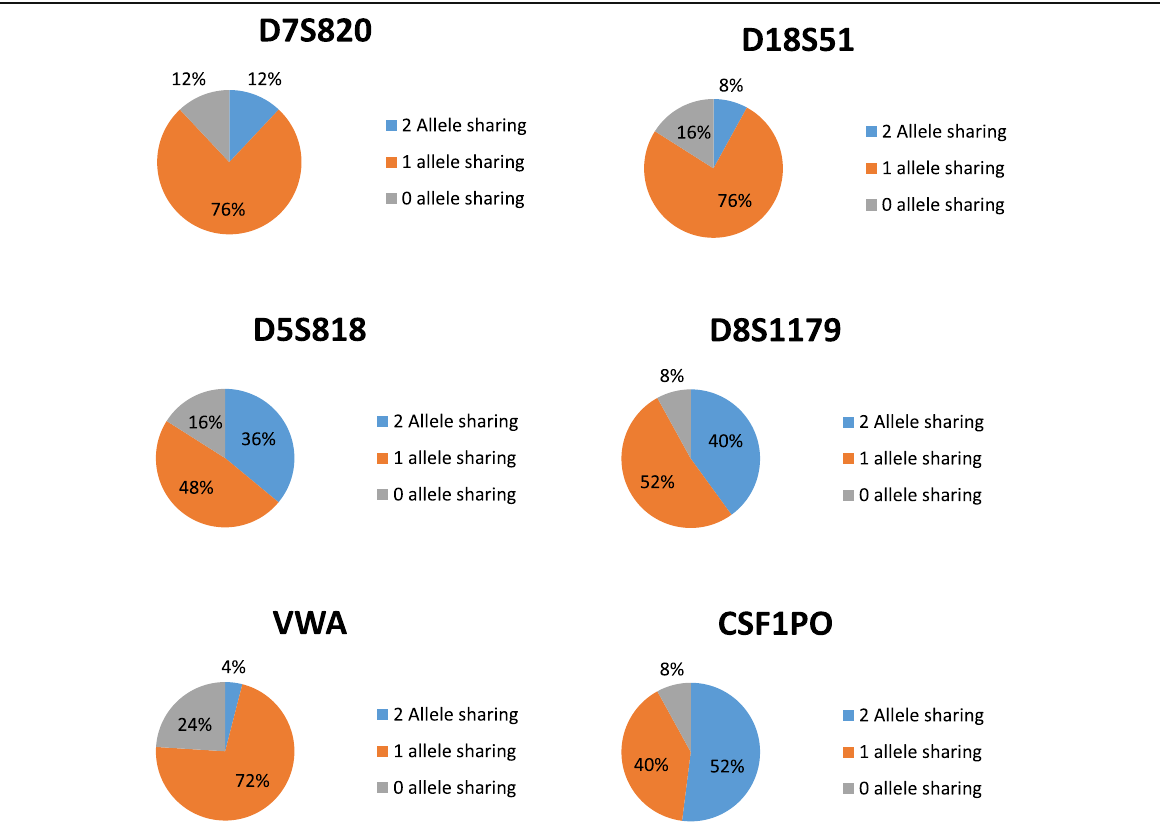
Fig. 3 Graph of allele sharing of full sibling from 12 examination